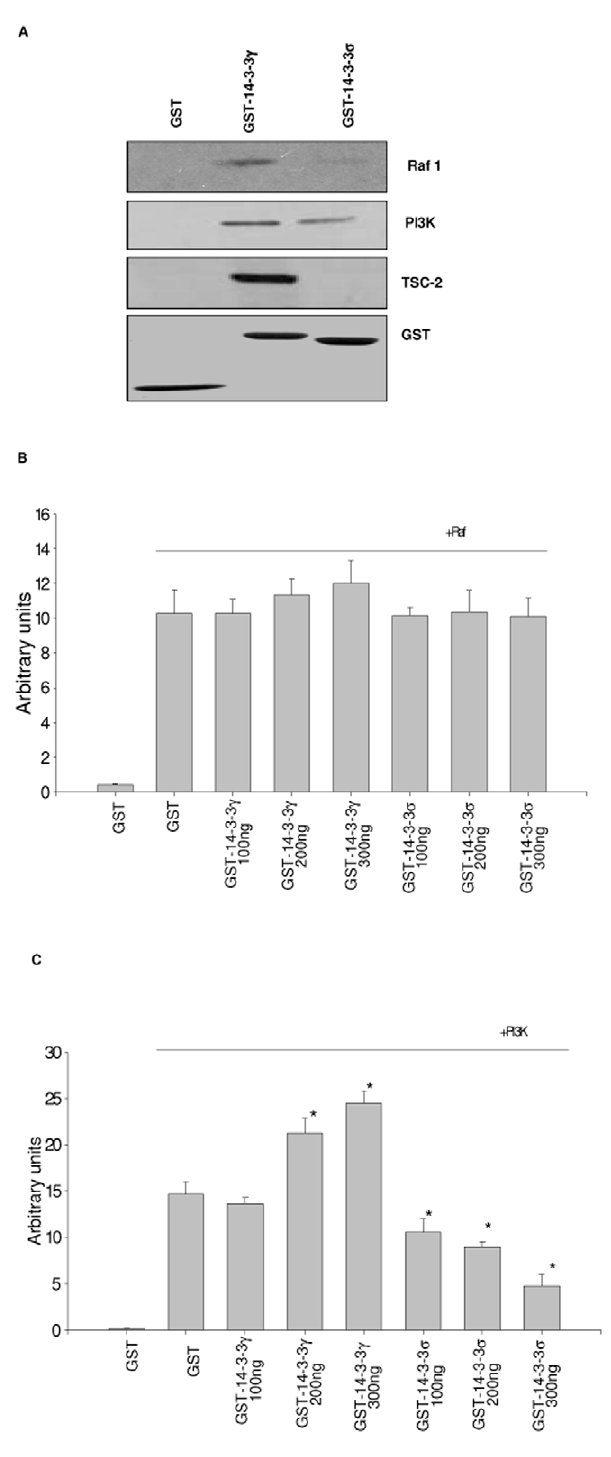
Figure 6. 14-3-3 c and 14-3-3 s interact with MAPK and PI3K components in vitro. (A) Glutathione-sepharose beads were loaded with purified recombinant GST-14-3-3 proteins and then incubated with cleared NIH3T3 cell lysates. The beads were washed and then the recovered proteins probed for the presence of Raf-1, PI3K p110 subunit, and TSC2 by immunoblotting with the appropriate antibody. A representative blot was stripped and reprobed with anti-GST antibody (bottom panel). (B) Raf-1 assay was performed on Raf-1 immunopre- cipitate in the presence of GST or GST-14-3-3 proteins using recombinant MEK protein as a substrate. The reaction mixture